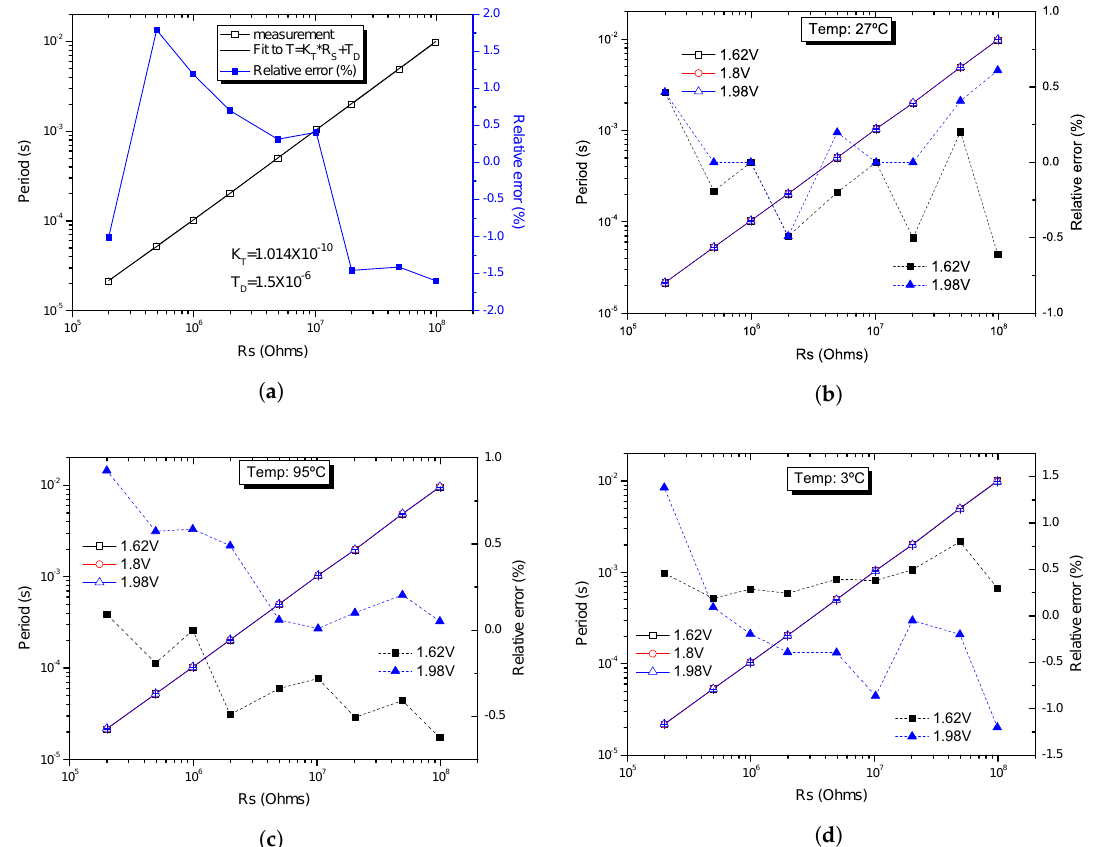
Figure 10. Output period vs. R S and: ( a ) corresponding linearity error; ( b ) corresponding relative error at different supply voltages ( ± 10% V DD ); ( c ) corresponding relative error at different supply voltages ( ± 10% V DD ) at 95 ◦ C; and ( d ) corresponding relative error at different supply voltages ( ± 10% V DD ) at 3 ◦